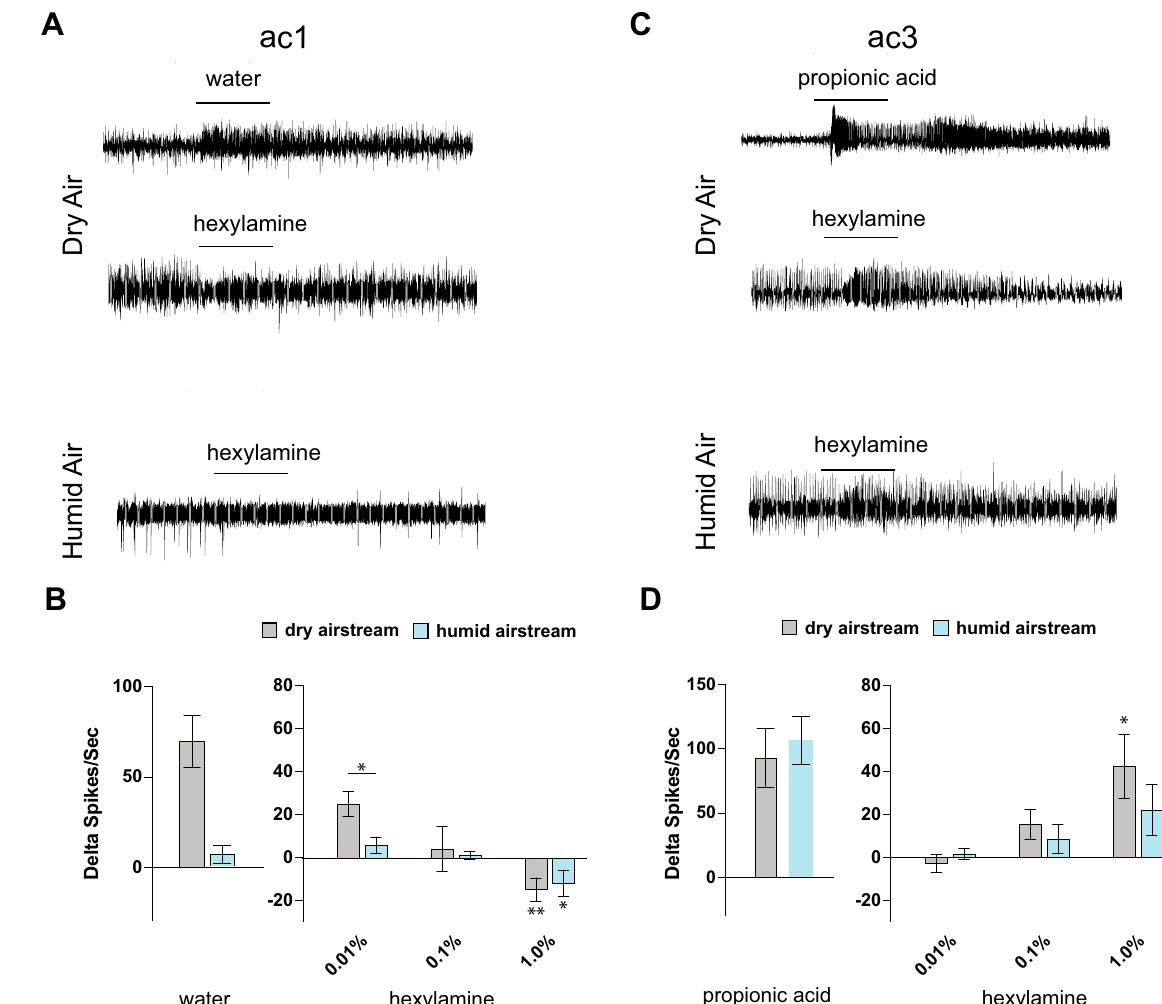
Figure 2. ( A ) Representative traces from the ac1 neurons for a 1-s period of stimulation with water vapor (top) and hexylamine (middle) in a dry air stream, as well as hexylamine (bottom) in a humidified air stream. Odorant headspace from a 10 –2 concentration solution was tested for each. ( B ) Mean responses. Each count was begun at the start of the increase in spike frequency. All compounds were dissolved in paraffin oil. All recordings were obtained from 3–5 days old wildtype (CS) flies. n = 5–6 sensilla from 5–6 flies. Error bars indicate s.e.m. * p < 0.05; ** p < 0.01. ( C ) Representative traces from the ac3 neurons for a 1-s period of stimulation of propionic acid (top) or hexylamine (middle) in a dry air stream, and hexylamine (bottom) in a humidified air stream. Odorant headspace from a 10 –2 concentration solution was tested for each. ( D ) Mean counts begun at the start of the increase in spike frequency. All recordings were obtained from 3–5 day old wildtype (CS) flies. n = 6 sensilla from 6 flies. Error bars indicate s.e.m. * p < 0.05. All compounds were dissolved in paraffin